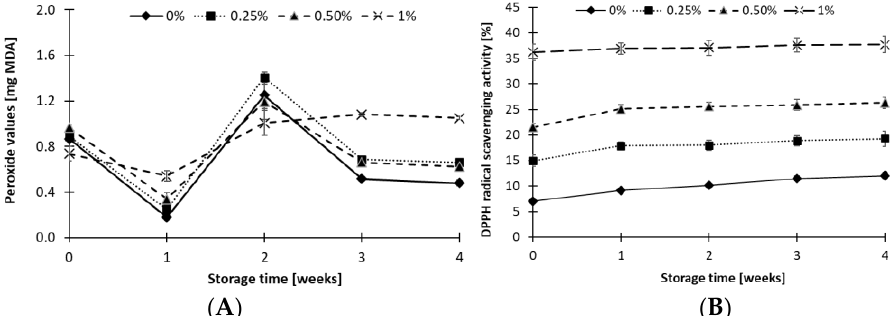
Figure 4. Peroxide value ( A ) and antioxidant activity measured by the DPPH scavenging assay ( B ) of acid curd cheese with different addition (0 – 1%) of astaxanthin lipid preparation (ALP) during 4 weeks of refrigerated storage (5 ± 1 °C). Antioxidant activity is expressed as percent of scavenging